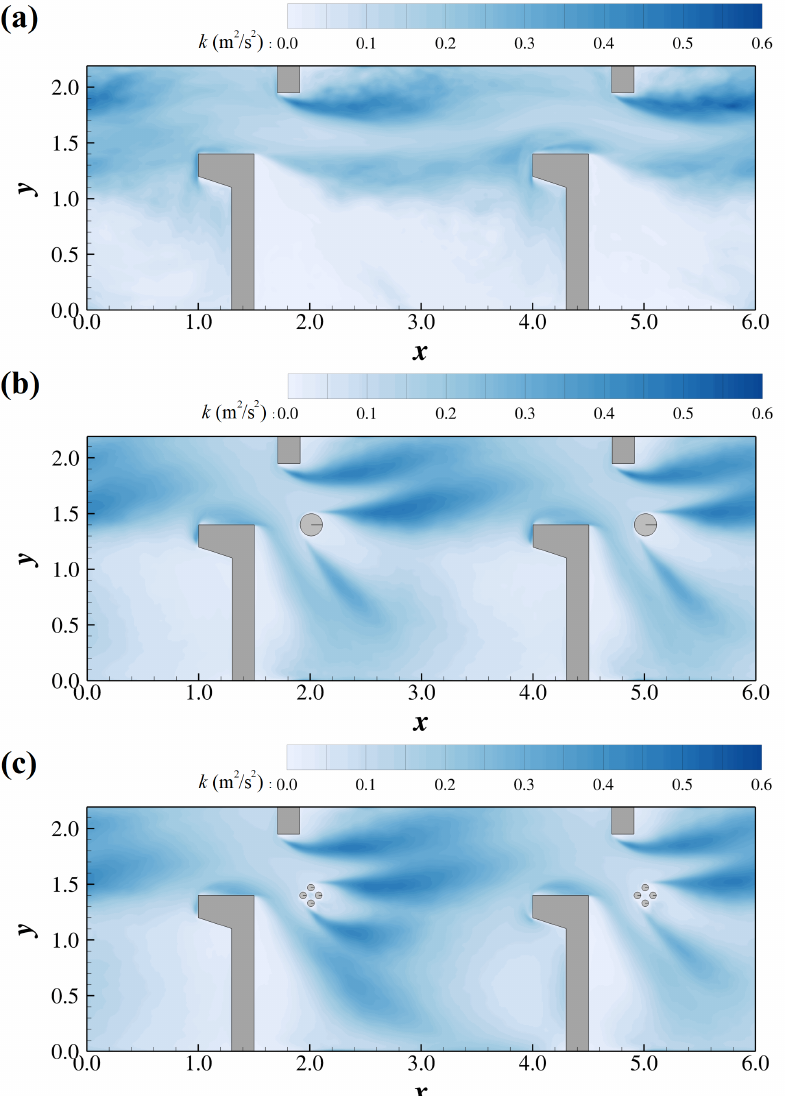
Figure 7. Contours of turbulence kinetic energy in a the horizontal plane at the half height of: ( a ) Case 1; ( b ) Case 2; ( c ) Case